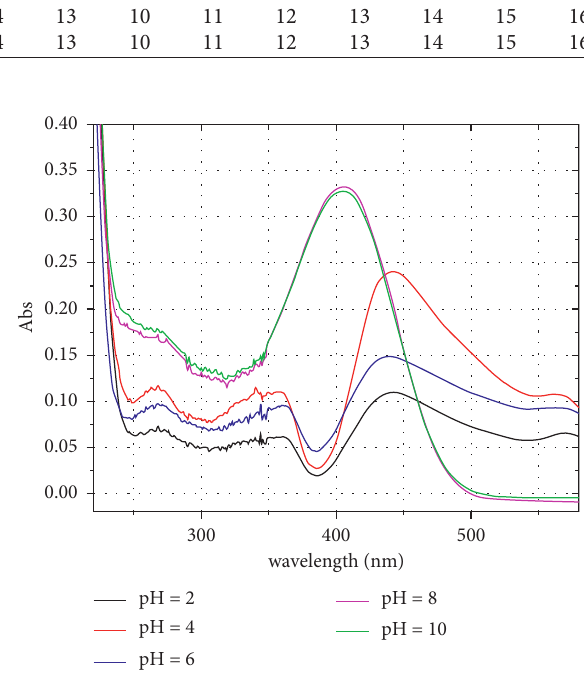
Figure 4: Absorption spectra of coumarin 3 (1 × 10 − 5 M) in aqueous ethanolic solutions of different pH